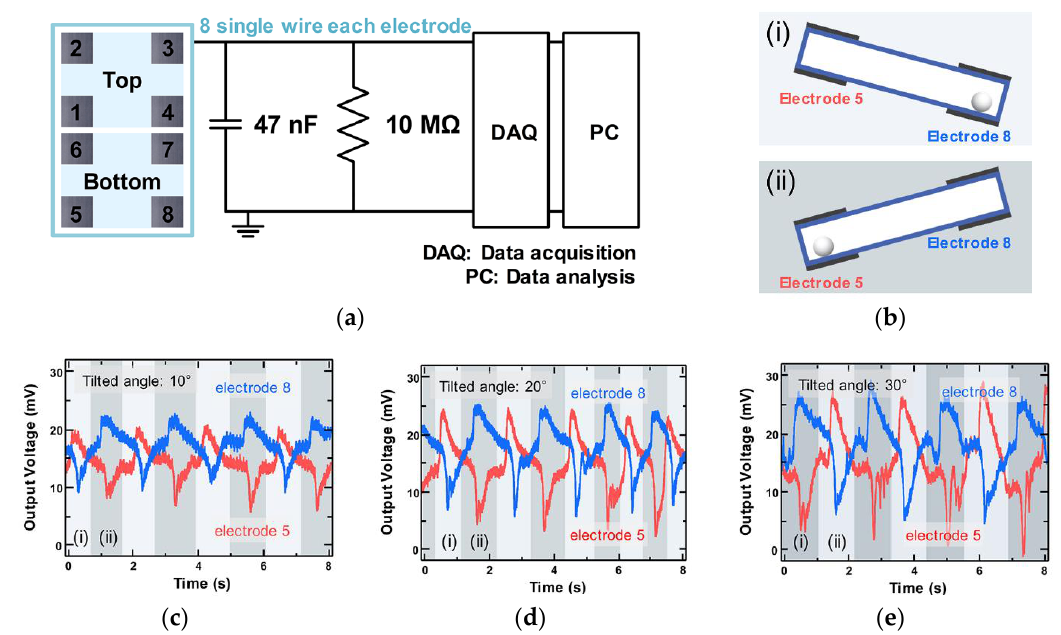
Figure 3. ( a ) Simple circuit diagram of a multi-channel system, including the eight electrodes located on the OT-TES. The data acquisition board (DAQ) conducts the data acquisition, and the personal computer (PC) analyzes the data. ( b ) Cross-sectional view of the OT-TES during tilting to the left and right side. ( c – e ) The DAQ output voltage measurements of a PTFE ball moving between two Al electrodes: ( c ) Tilt OT-TES at 10°; ( d ) tilt OT-TES at 20°; and ( e ) tilt OT-TES at 30°.